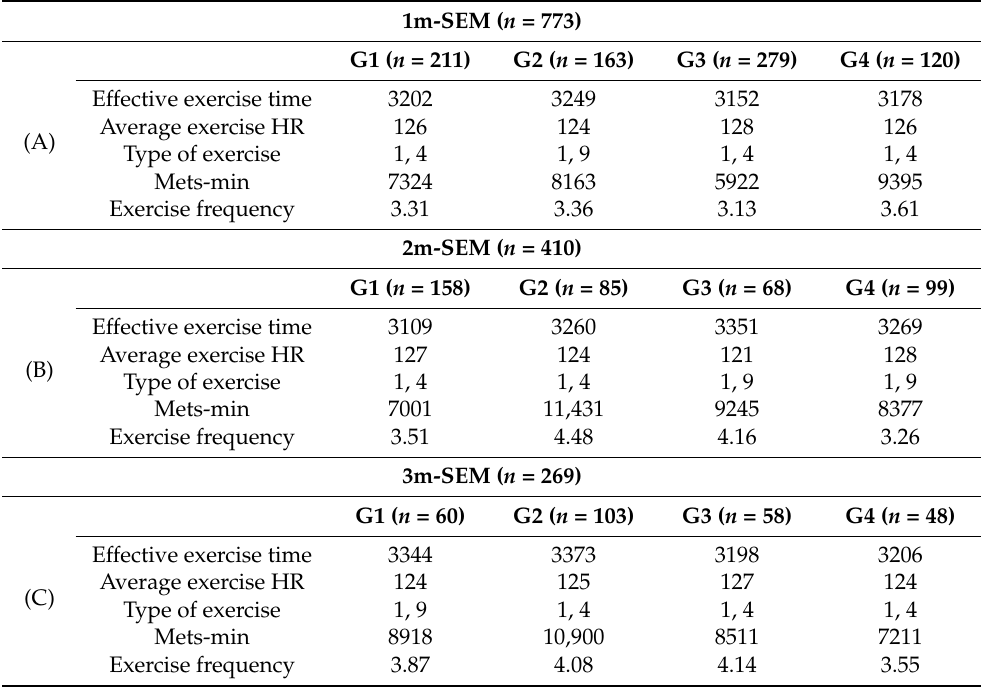
Table 3. ( A ). The recommended exercise indices of 1m-SEM in each group; ( B ). The recommended exercise indices of 2m-SEM in each group; ( C ). The recommended exercise indices of 3m-SEM in each group. Unit of effective exercise time: Seconds/each single exercise. Unit of average exercise HR: BPM/each single exercise. Type of exercise: ‘1 (cid:48) refers to running, ‘4 (cid:48) refers to hiking, ‘9 (cid:48) refers to indoor exercise. Unit of Mets-min: (METs × minute)/per month. Unit of exercise frequency: times/each week. G1: group 1. G2: group 2. G3: group 3. G4: group